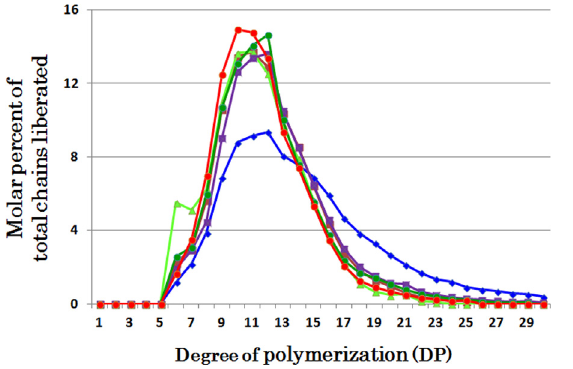
Fig 9. Chain-length preference of isoamylase-type debranching enzymes in debranching of amylopectin. The amount of chains liberated after enzymatic reaction with amylopectin and OsISA1 (blue ♦ ), OsISA3 (brown ■ ), CytISA (green ▲ ), ScoISA (purple ■ ), EcoGlgX (dark green ● ), and PsaISA (red ● ), respectively. The total amounts of liberated chains out of total chains of the substrate glucan amylopectin (566 nmoles) by reactions with OsISA1, OsISA3, CytISA, ScoISA, EcoGlgX, and PsaISA were 63, 74, 116, 28, 59, and 89 nmoles, respectively. These data were chosen from Fig 2, S3, S4, S5, S6 and S7 Figs,